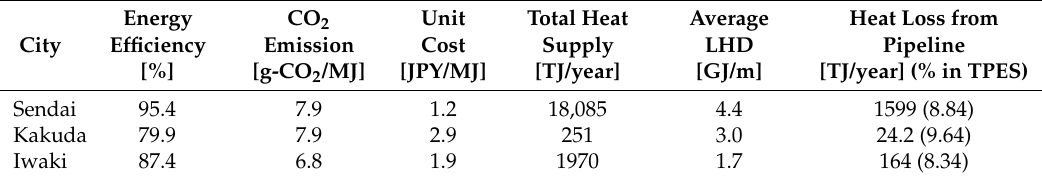
Table 4. DHS characteristics for three cities.